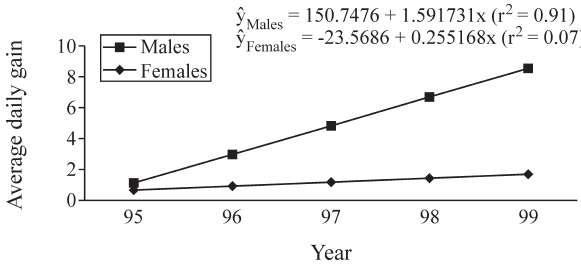
Figure 4 - Direct genetic trends for average daily weight gain (g) from 1995 to 1999.